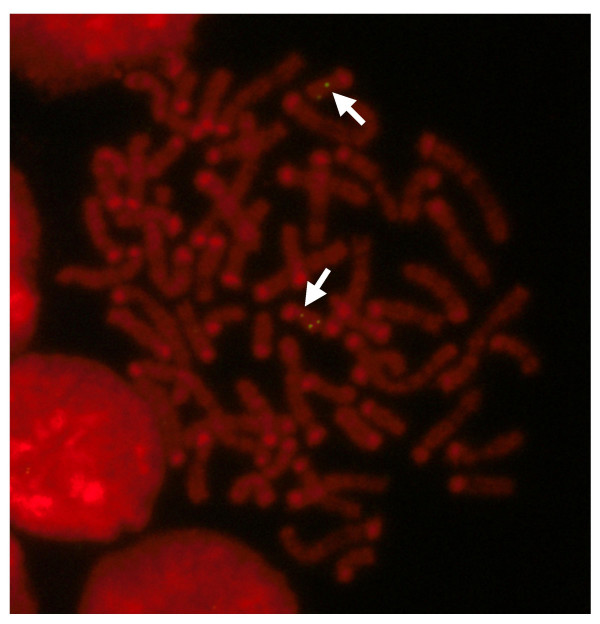
FISH analysis of R-banded metaphase spreads from peripheral blood with a goat uromodulin promoter probe. The arrows indicate the localization of the uromodulin gene on goat chromosome #25, whereas the signal of the BAC clone (EPO) was used for chromosome assignment.